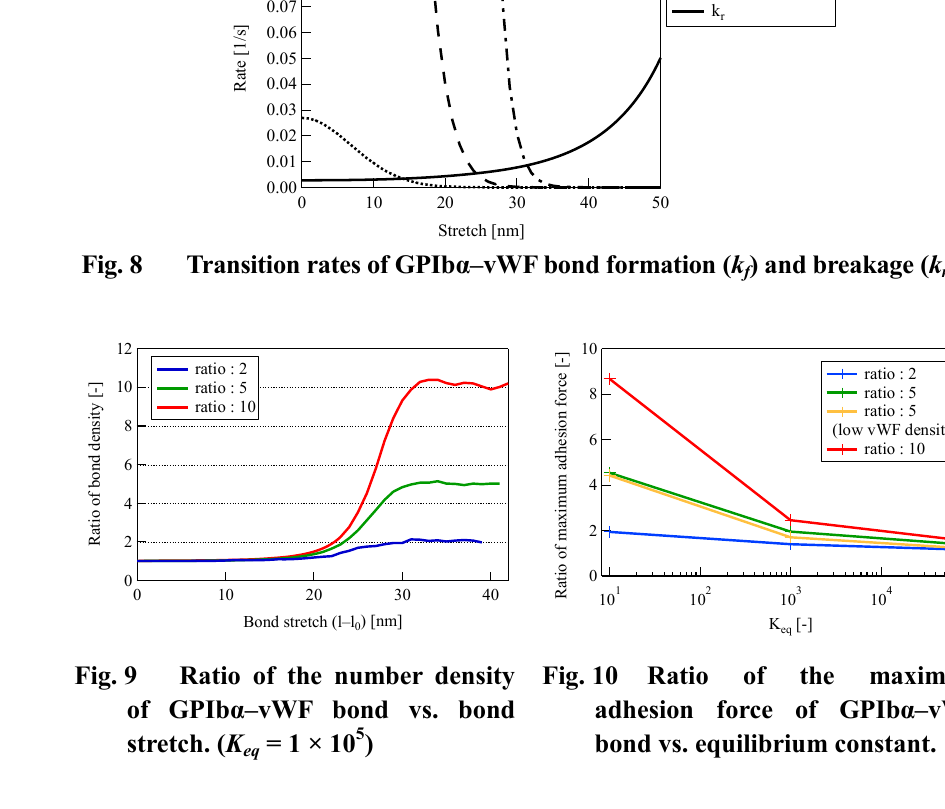
Fig. 9 Ratio of the number density Fig. 10 Ratio of the maximum of GPIb α –vWF bond vs. bond adhesion force of GPIb α –vWF = 1 × 10 5 ) stretch. ( K bond vs. equilibrium eq